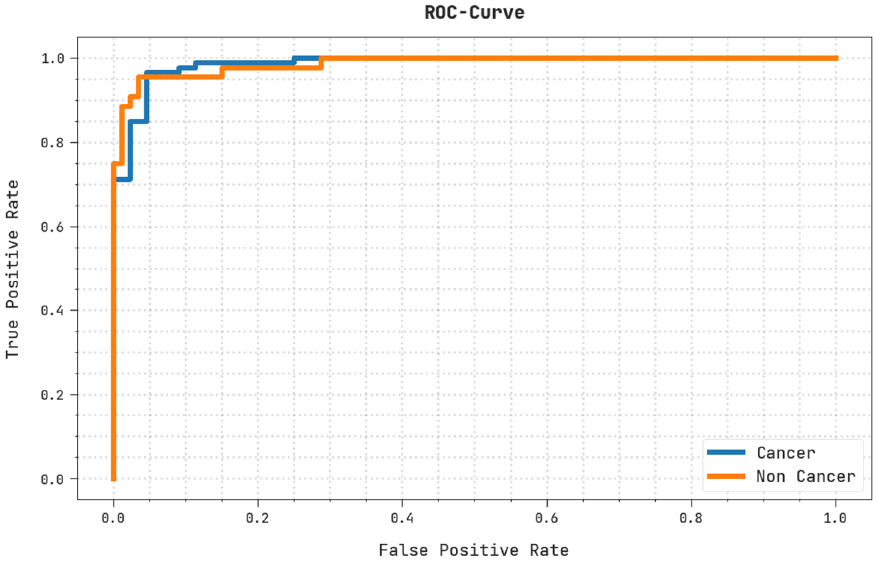
Figure 11. ROC analysis of OIDCNN-OPMDD approach. Table 6. Comparative analysis of OIDCNN-OPMDD approach with existing algorithms [10,19].